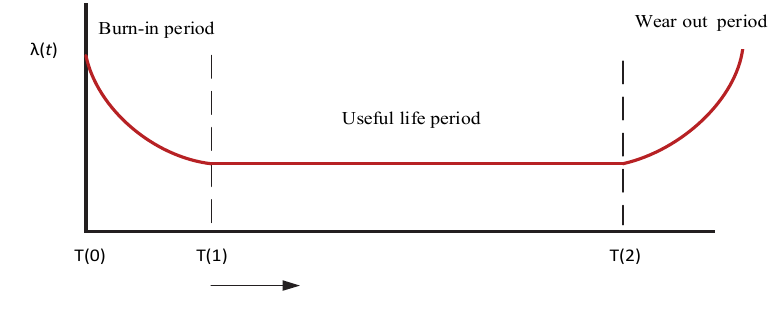
Fig. 2. Bathtub failure rate